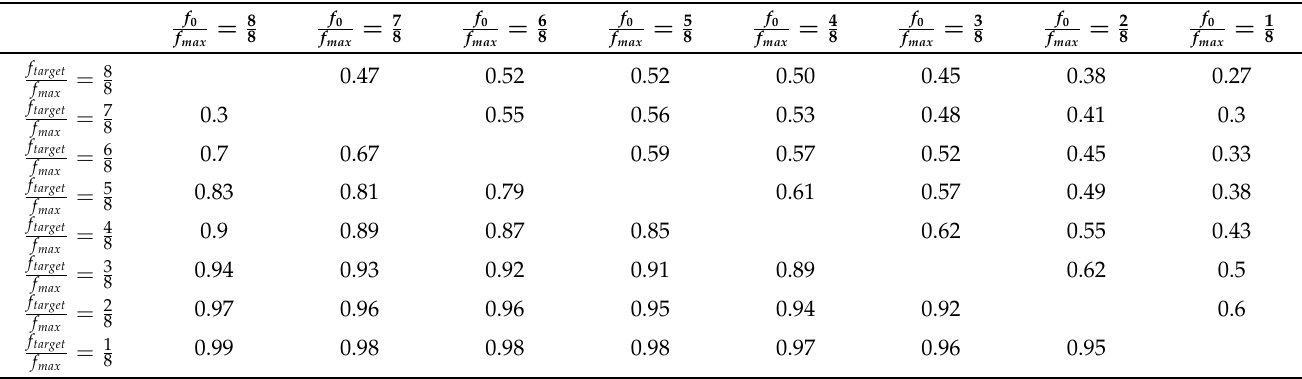
Table 2. Threshold list with an 8-frequency